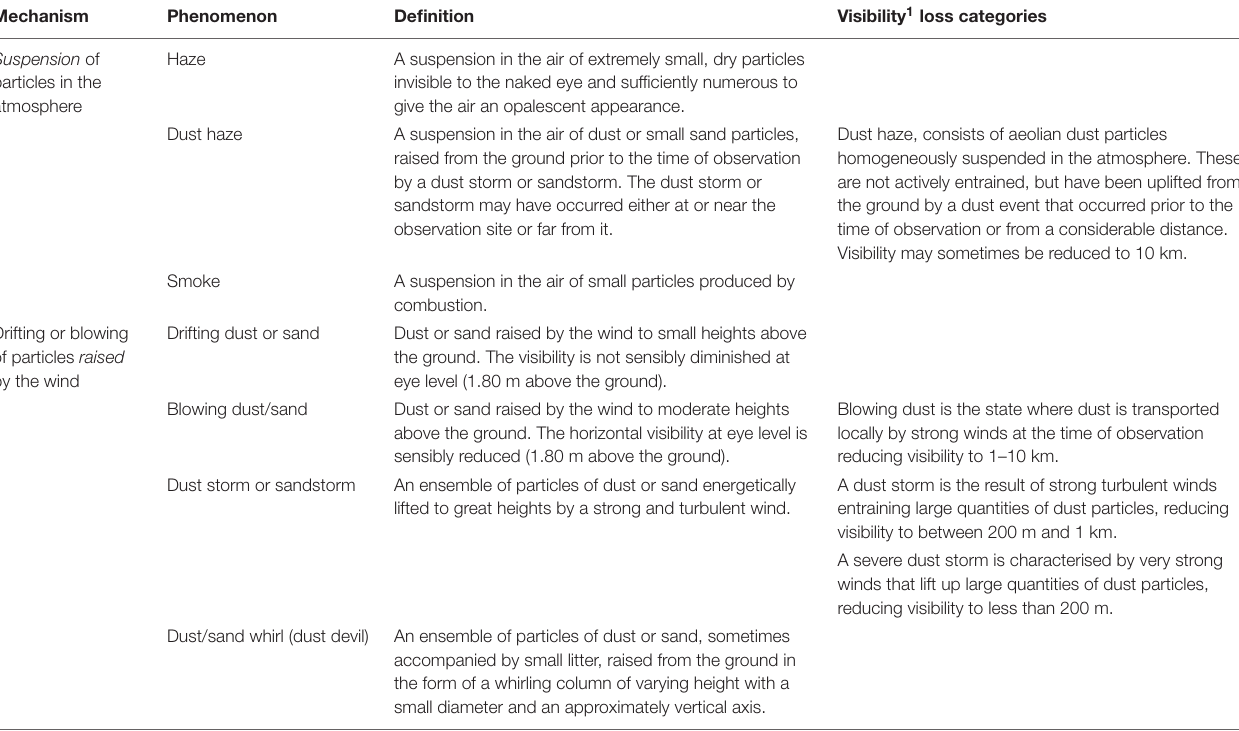
TABLE 1 | Lithometeors classification according to the World Meteorological Office (WMO,